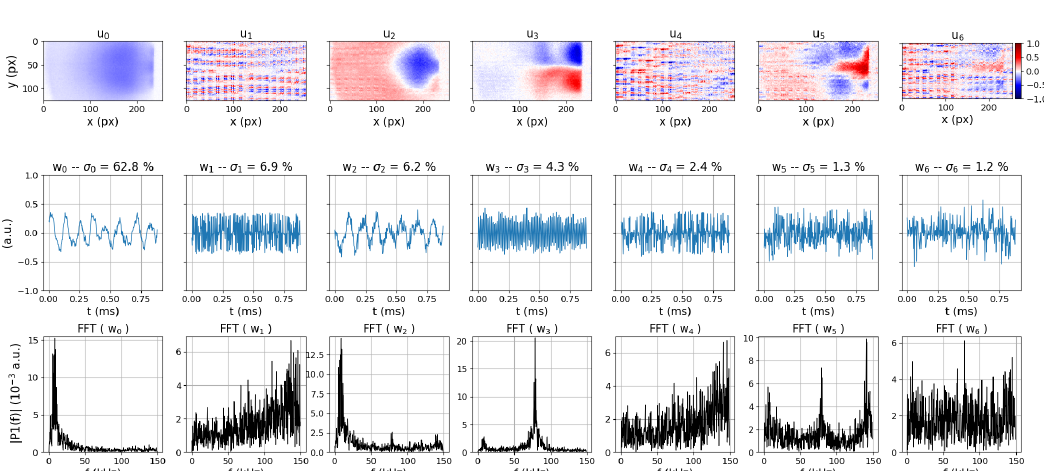
Figure 6. Nominal regime : POD analysis of the side videos with a discharge voltage U d = 200 V, a mass flow rate Q = 1.8 mg · s − 1 , a cathode current I H = 20.05 A ( I H / I H , crit = 1.09) and a acquisition frequency of F fps = 300 kfps. (Top) Spatial POD modes u i ; (Middle) corresponding temporal POD modes w i with their singular value λ i given as σ i = λ 2 over the sum of all the λ i expressed as a percentage; and i (Bottom) corresponding